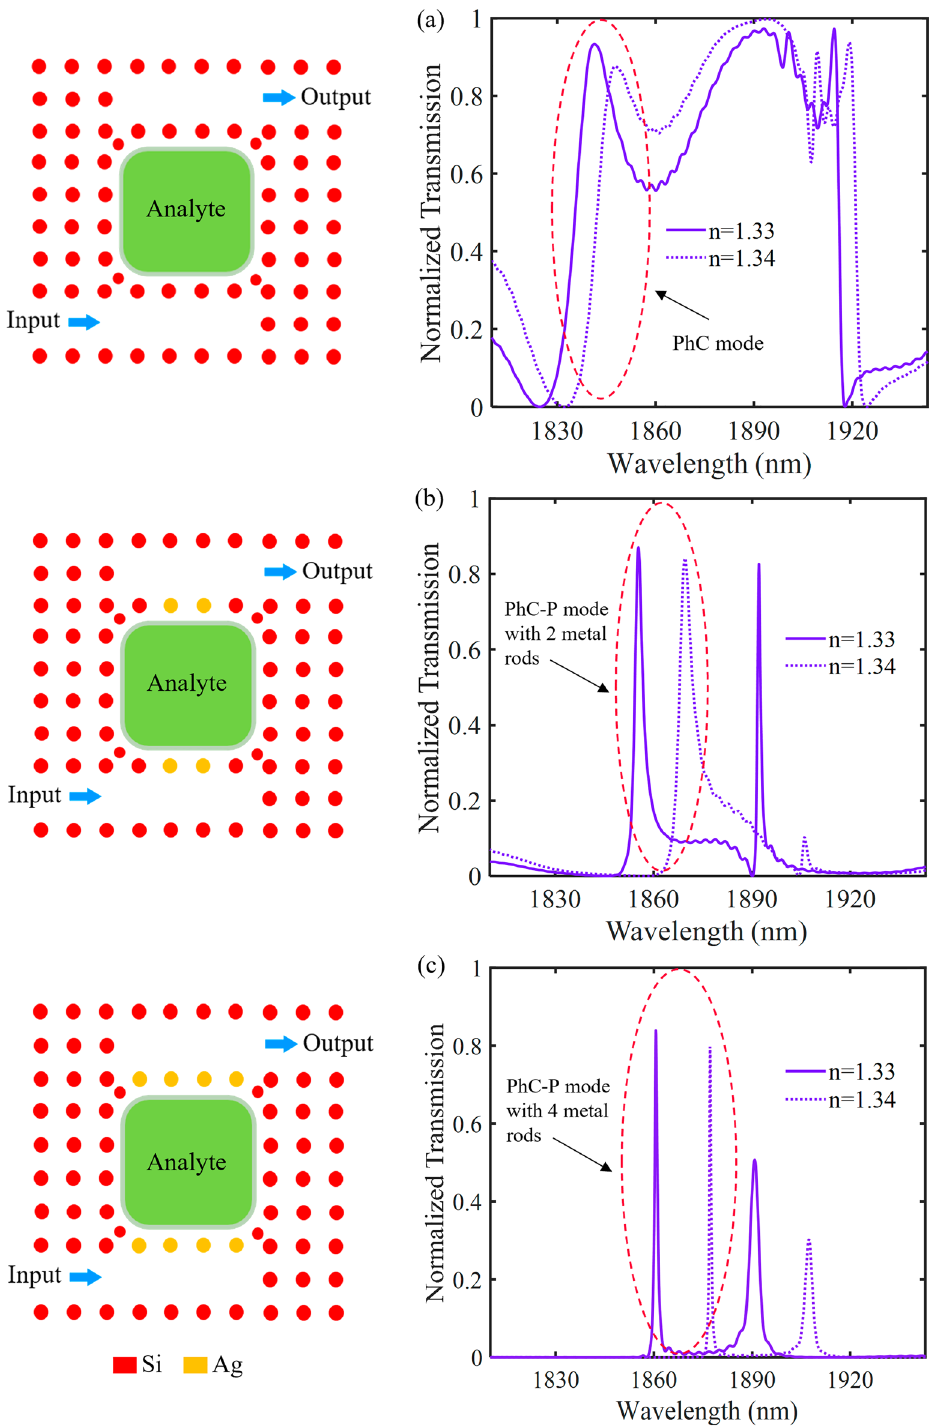
Figure 8. The effect of analyte RI variation on the transmission spectrums of three RI sensor structures including ( a ) PhC sensor without metallic rods, ( b ) hybrid P-PhC sensor with two metallic rods, and ( c ) proposed hybrid P-PhC sensor with four metallic rods in coupling